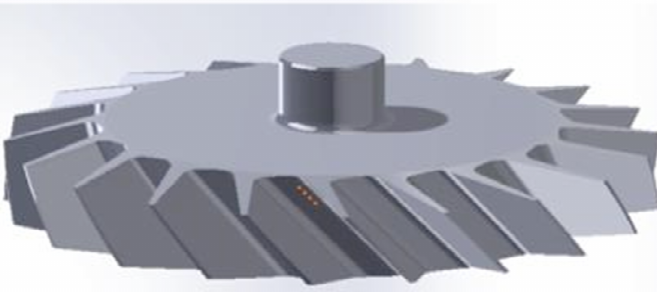
Figure 5. CAD model of the demonstrator geometry for a blisk.